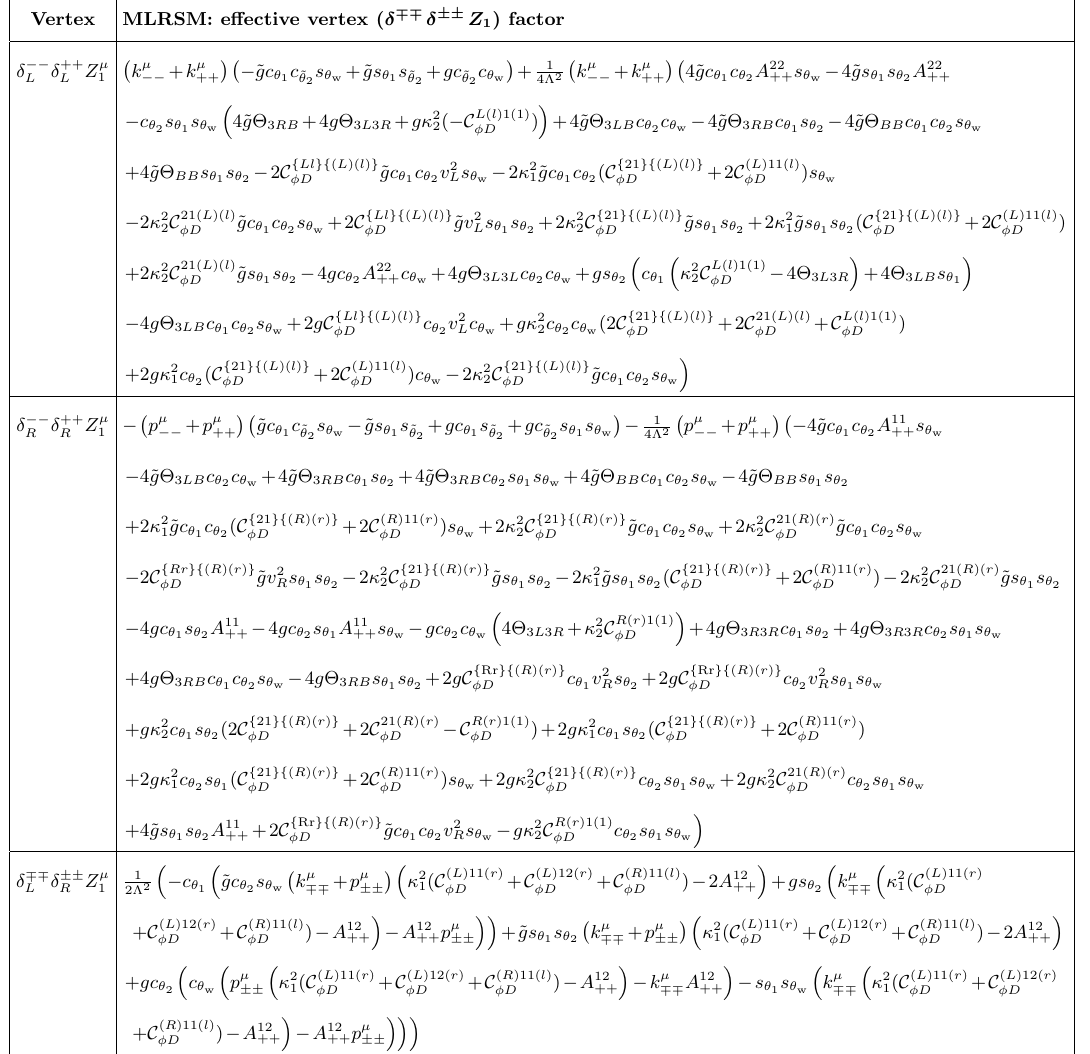
Table 40. MLRSM: coupling of a pair of doubly charged scalars ( (cid:14) (cid:6)(cid:6) ) with a neutral gauge boson ( Z 1 ). Here, s (cid:18) = sin (cid:18) i and c (cid:18) = cos (cid:18) i . k (cid:22) and p (cid:22) are the four momenta of (cid:14) (cid:6)(cid:6) (cid:6)(cid:6) (cid:6)(cid:6) i i respectively. ~ (cid:18) 2 is the rede(cid:12)ned angle de(cid:12)ned in eq. (6.102)